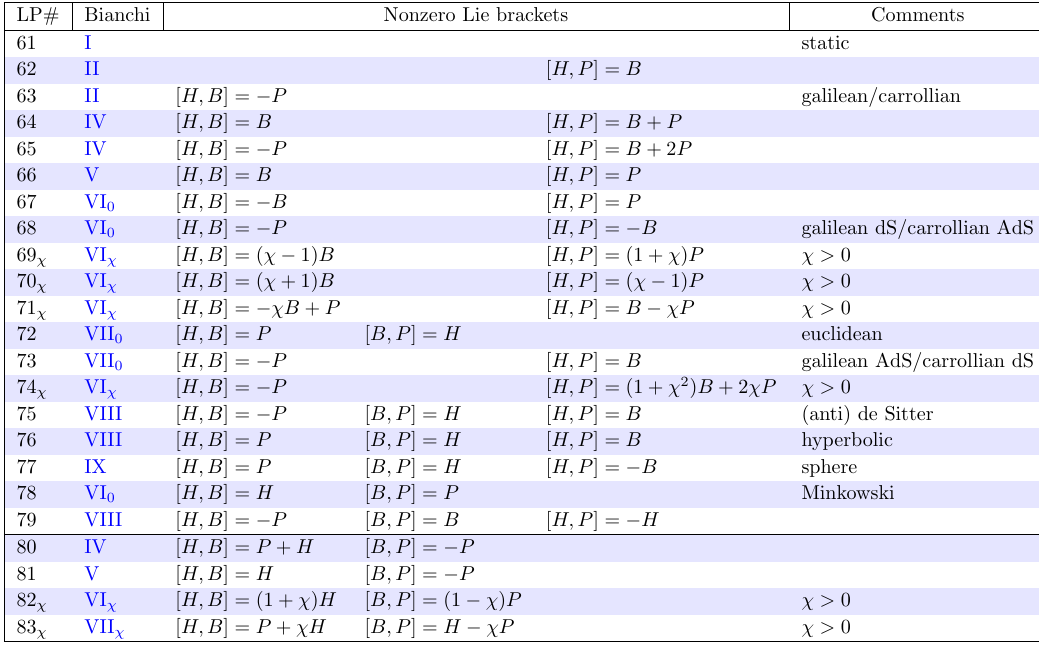
Table 12 . Lie pairs for kinematical Lie algebras ( D =